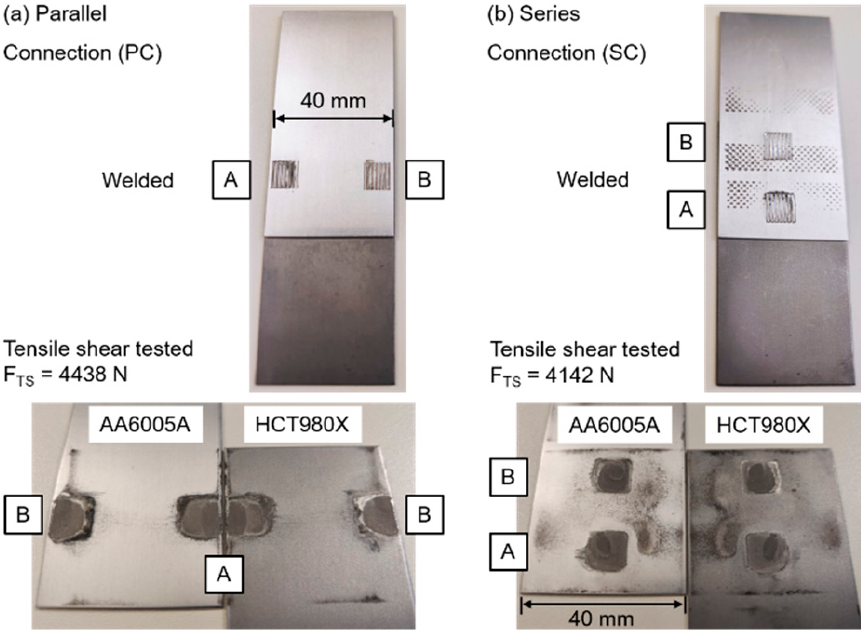
Figure 4. Weldedandtensilesheartestedsamplesfor( a )parallelconfigurationand( b Figure 4. Welded and tensile shear tested samples for ( a ) parallel configuration and ( b ) series configuration.